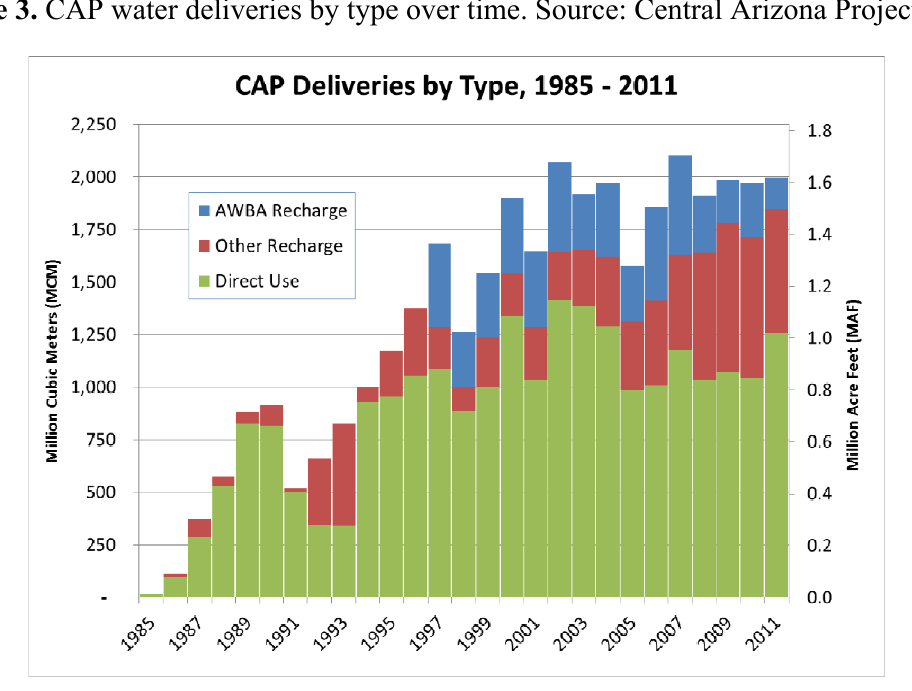
Figure 3. CAP water deliveries by type over time. Source: Central Arizona Project